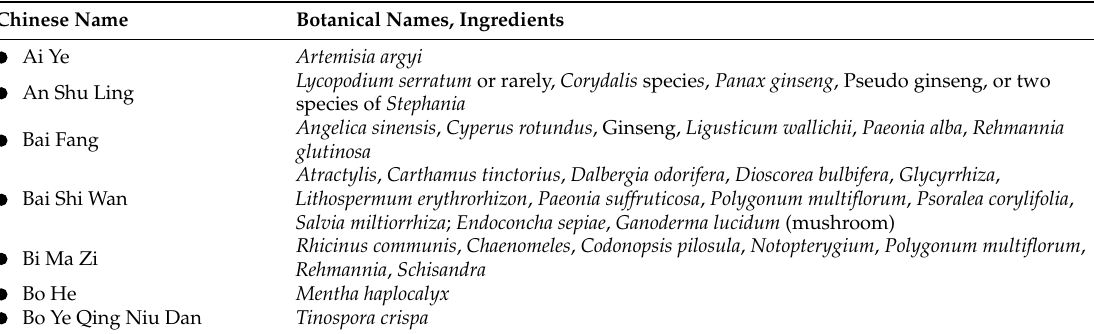
Table 11. Listing compilation of TCM herbs and herbal products with reported